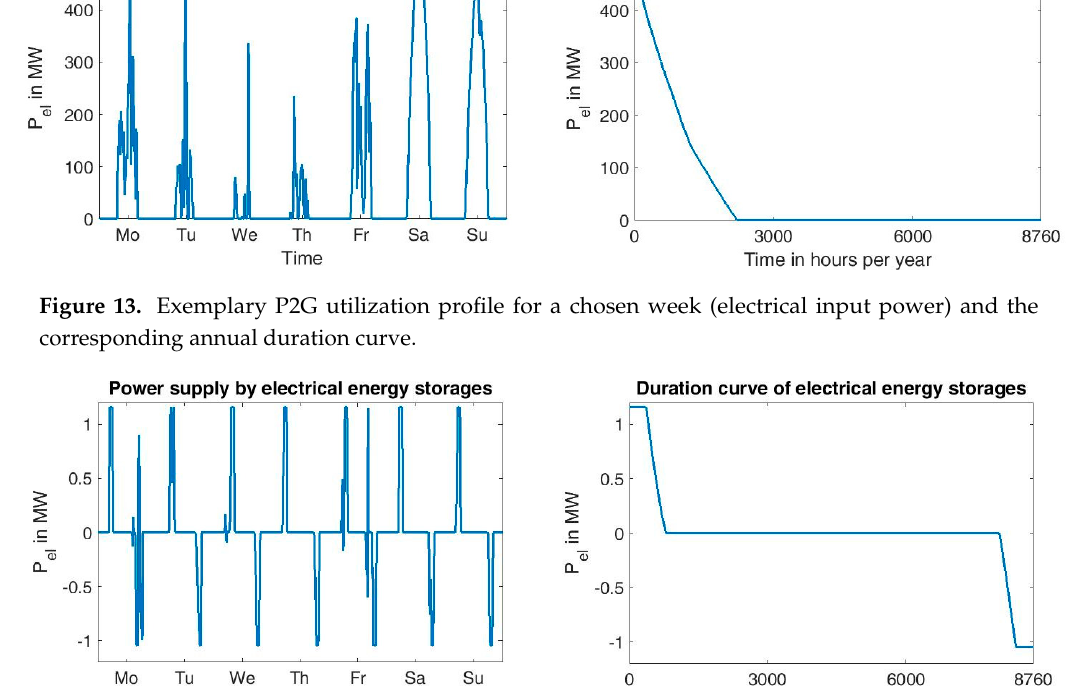
Figure 14. Exemplary charging/discharging power of a selected electrical energy storage unit and the corresponding annual duration curve.